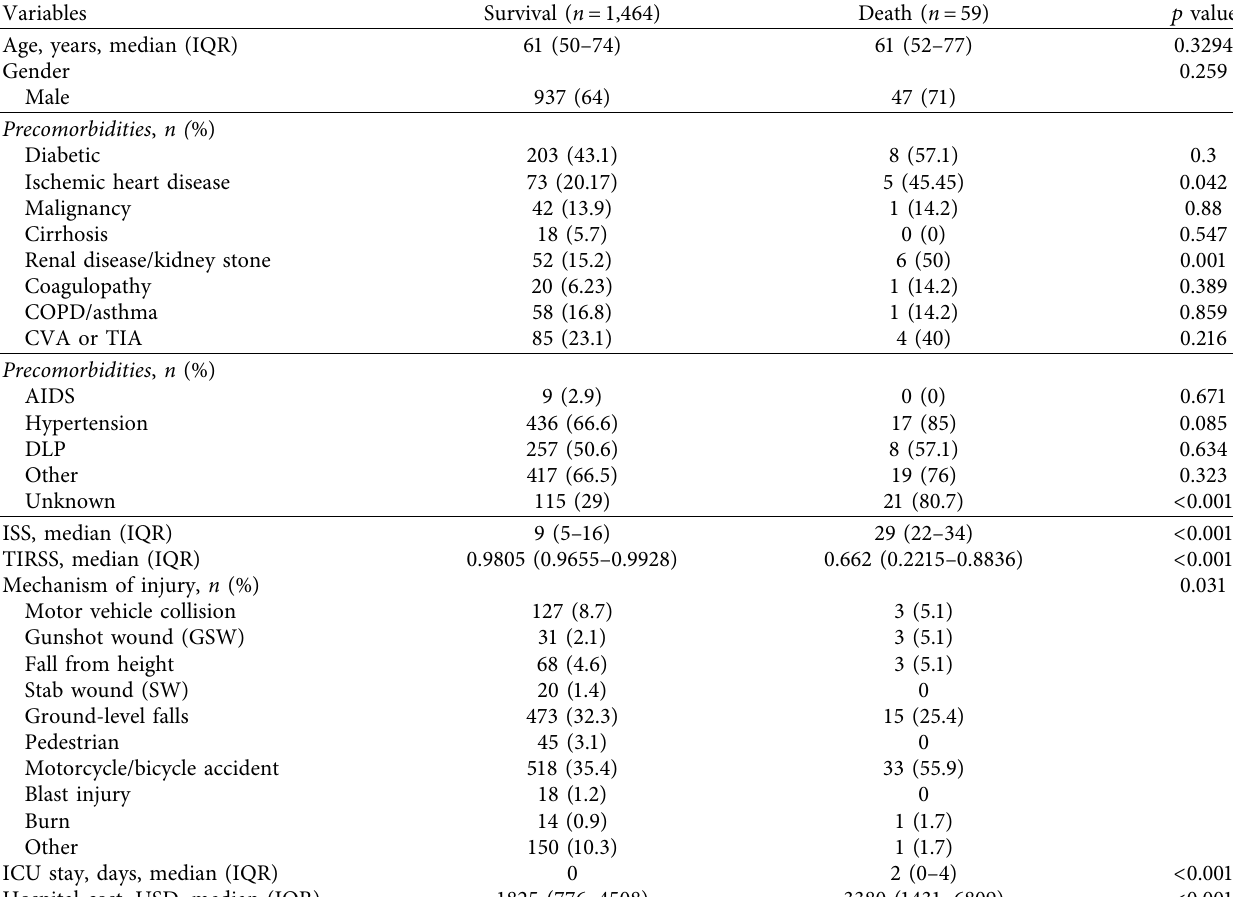
Table 1: Characteristics of patients compared between the survival group and death group.